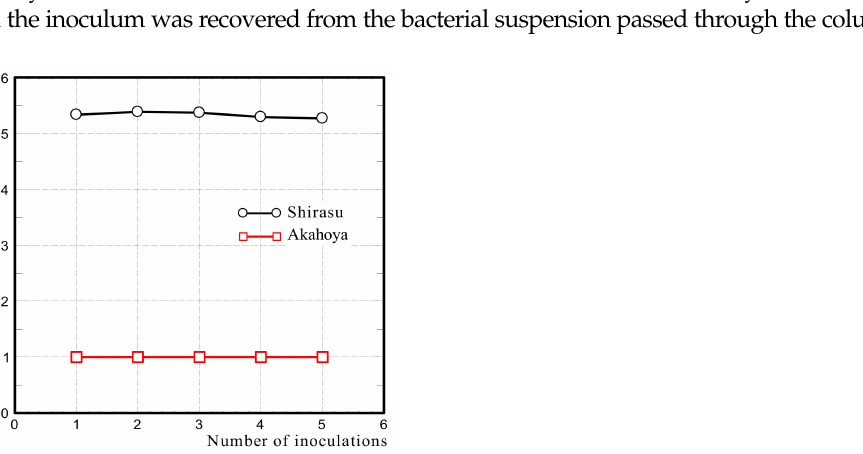
Figure 18. Number of E. coli (log cfu/mL) after passing through the column containing Akahoya or